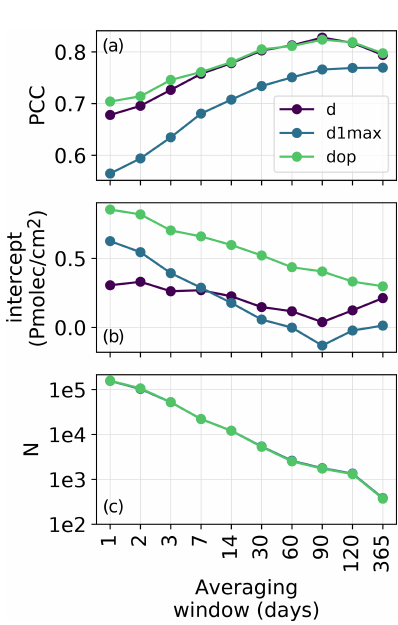
Figure 5. Pearson correlation coefficient (a) , intercept (b) and num- ber of points (c) of the least square linear regression of TROPOMI TrC-NO 2 versus surface NO 2 mixing ratio for different time win- dows. Results are shown at daily mean (d) and daily 1h maximum (d1max) scales as well as during daily TROPOMI overpass times